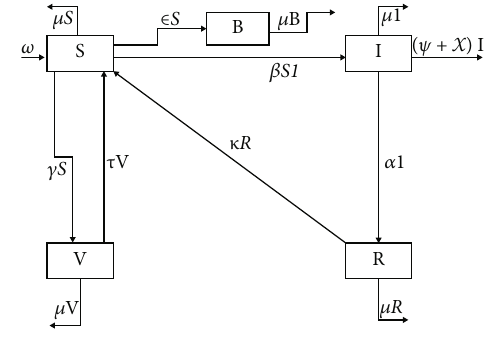
Figure 1: Schematic diagram of the transmission dynamics of bovine brucellosis in cattle with